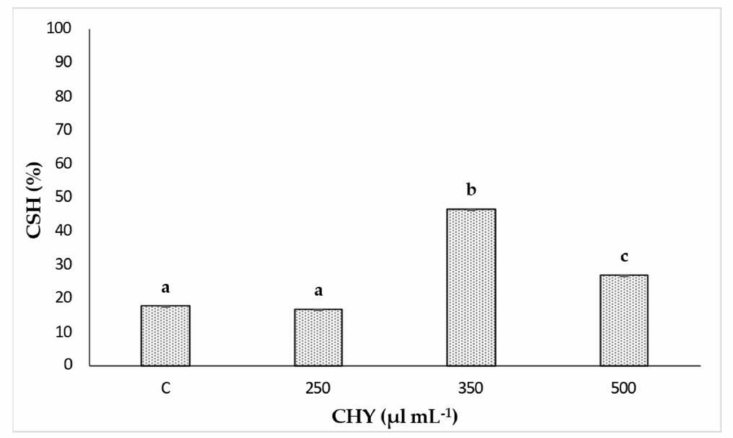
Figure 4. Cell surface hydrophobicity (%CSH) values observed for L. monocytogenes ATCC 7644 after exposure to 250, 350 and 500 µ L mL − 1 of CHY for 1 h at 37 ◦ C. Control (C) corresponds to the untreated sample. Results are means of three biological repetitions and the bars indicates the standard deviations. Different letters indicate significant differences ( p < 0.05) on %CSH among treatments with three CHY